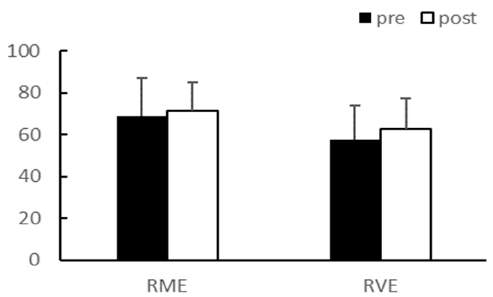
Figure 5. LDL (mg/dL). LDL, Low-density lipoprotein; * p < 0.05.